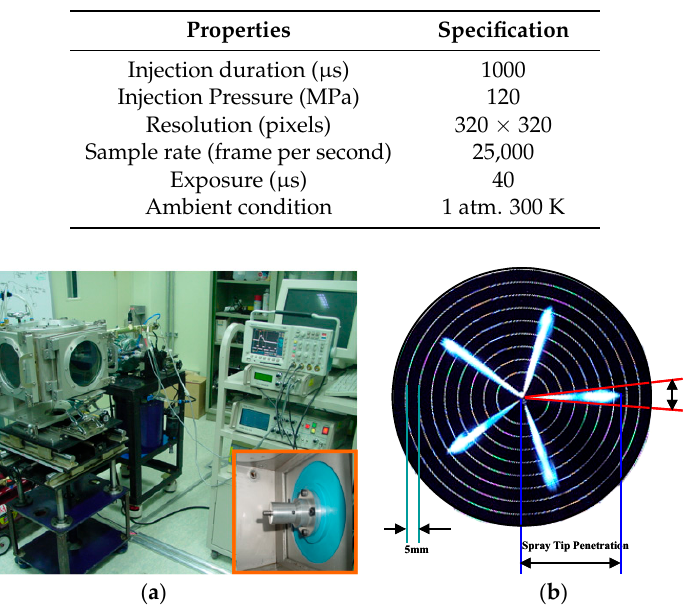
Table 4. Experimental conditions for spray visualization.